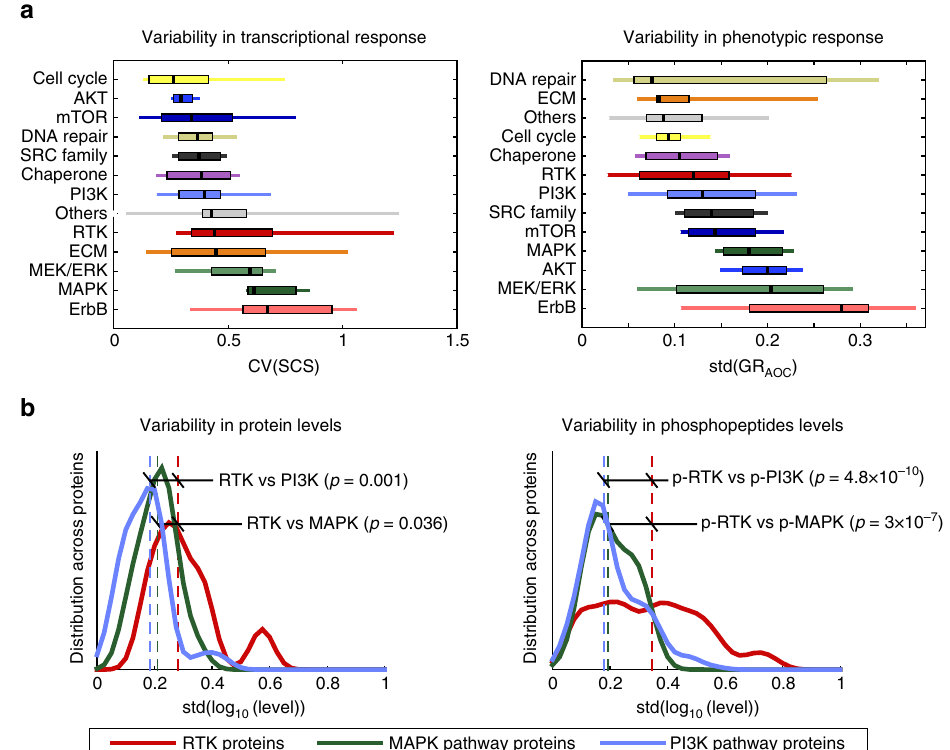
Fig. 3 Variation in L1000 signature and phenotypic response with drug class. a Boxplots of the distributions of the coef fi cient of variation of the signature consistency score at 24 h, a measure of differences in L1000 signature at all tested doses, by drug target class sorted by the median across all six cell lines (left). Boxplots of the distribution of the standard deviation of the GR AOC (a measure of phenotypic response across all doses for a particular drug) by drug class sorted by the median across all six cell lines (right). Black lines represent the median, boxes the interquartile range, and upper and lower lines the 5 and 95% quantiles. b Distribution of standard variation of protein (left) and phospho-peptide (right) levels across six cell lines as measured by shotgun mass spectrometry for proteins in the MAPK and PI3K pathways and of RTKs. On each graph the signi fi cance of the difference in distribution between RTK and signaling pathways is indicated. The identities of proteins included in this analysis, as well as complete mass spectrometry pro fi les, are included